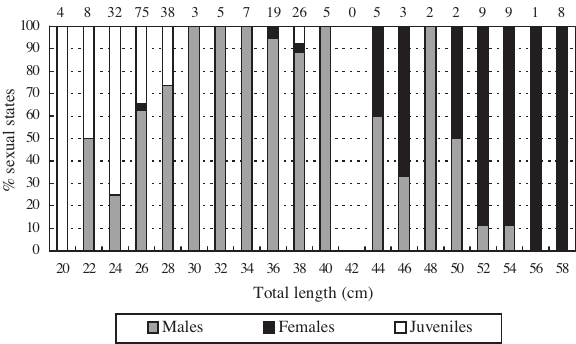
F IG . 4. – Frequency of different sexual states of gilthead seabream in Mellah lagoon as a function of total length. 265 Samples were collected in the months of November and December (see values above).